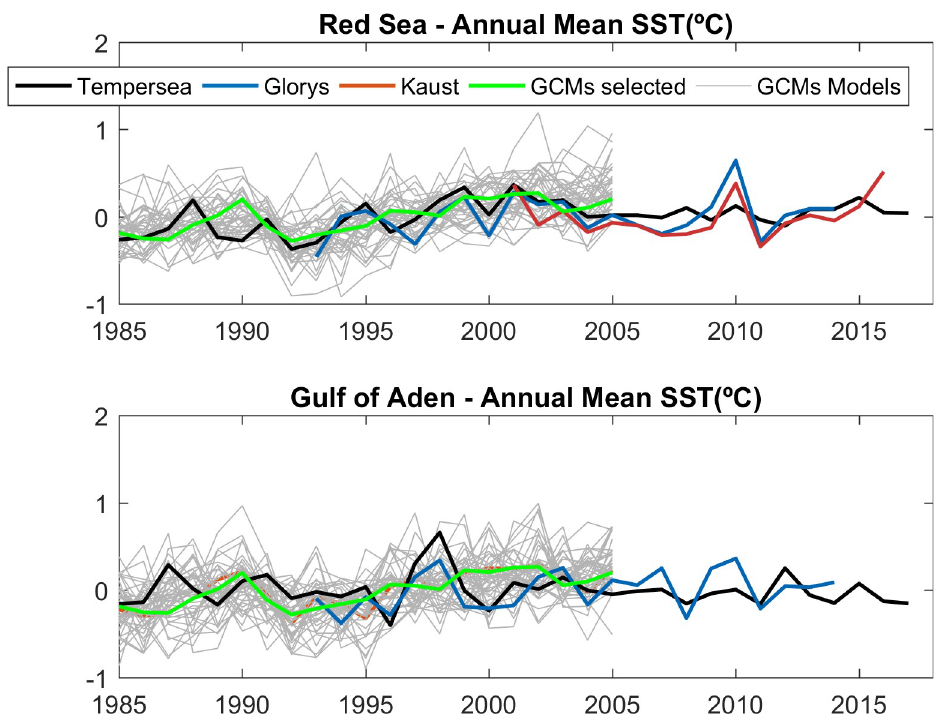
Fig 6. Annual Mean SST anomalies (˚C) in the Red Sea (Top) and in the Gulf of Aden (bottom) for the observations (black line), KAUST (red line), GLORYS (blue line), GCMs (grey lines) and the average of the selected GCMs (see “Model Selection” section; green line). Anomalies are computed with respect to the 1985–2005 average.